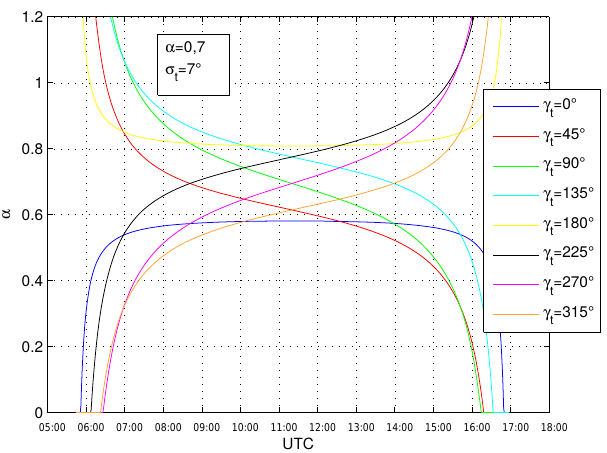
Figure 4. Diurnal variations of albedo with a constant true albedo and a constant tilt of the slope but differing